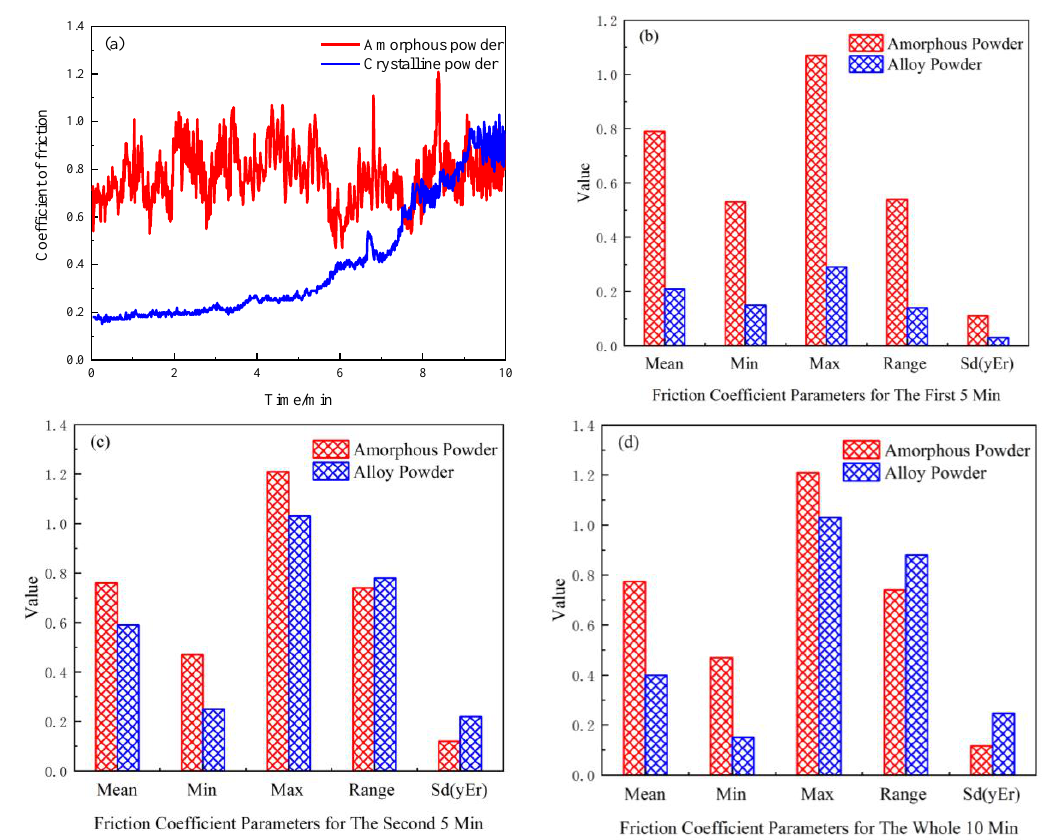
Figure 6. ( a ) Curve of friction coefficient of amorphous alloy powder and crystalline powder cladding sample; ( b ) Parameters of friction coefficient for the first five minutes; ( c ) Parameters of friction coefficient for the last five minutes; ( d ) Parameters of friction coefficient for the whole ten minutes.